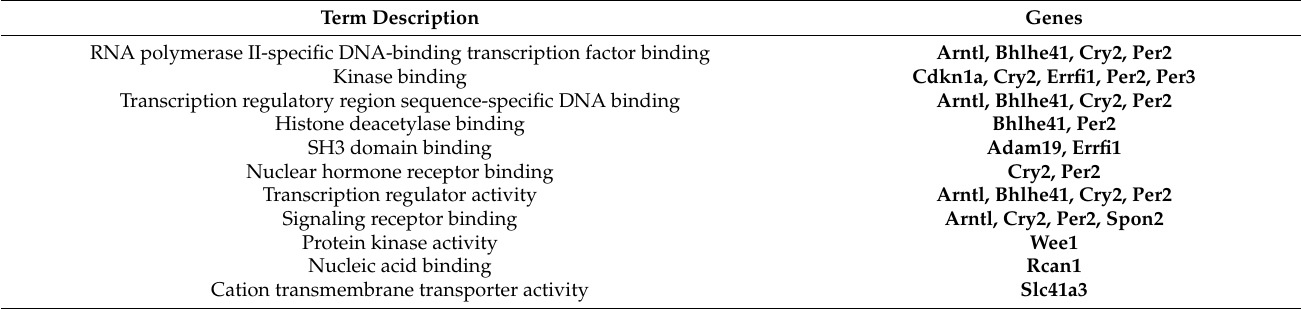
Table 4. Molecular signaling activities of 12 overlapping differentially expressed genes.